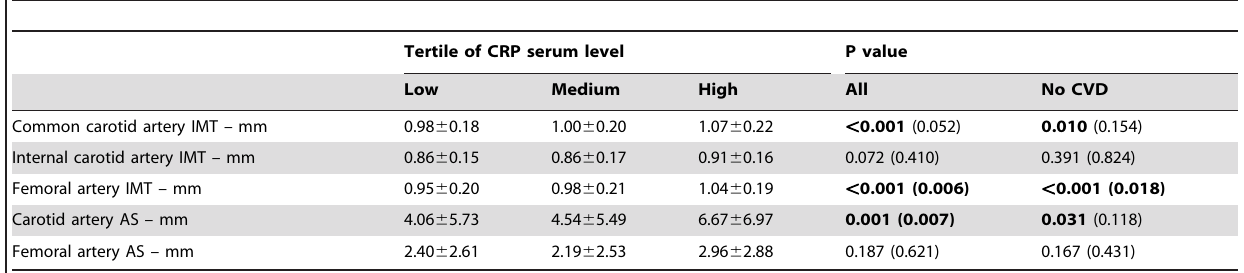
Table 4. Measures of carotid and femoral artery atherosclerosis according to CRP tertile groups in the Bruneck Study.